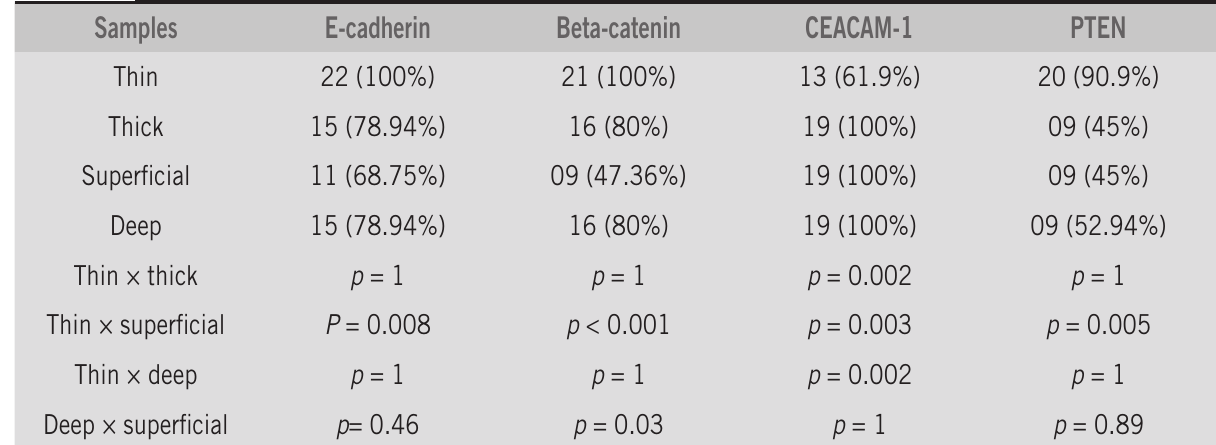
Positive immunohistochemical tests (global positivity) in superficial and deep samples of thick Table 2 melanomas ( n = 21) and in thin melanomas ( n = 22) with samples comparation and p value